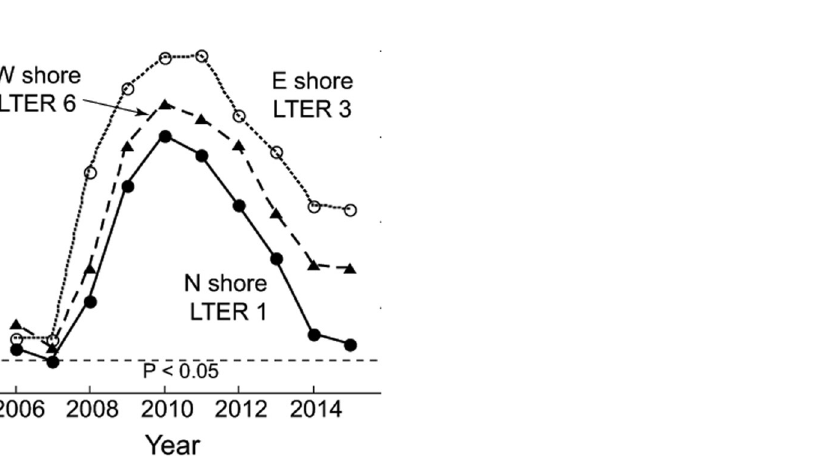
Figure 6. Results of post-hoc multiple contrasts (using t-tests, t values plotted) between multivariate community structure by functional group (see Fig. 5b) in 2005 versus the remaining 10 years for three sites. Analyses were conducted separately by site using PERMANOVA with years and time as factors in a repeated measures design with quadrats as replicates. Horizontal dashed line shows the critical value of t that identifies statistical significance (at P <